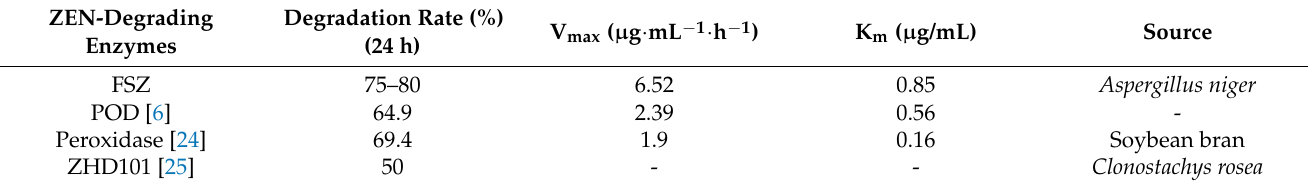
Figure 4. Degradation kinetics of FSZ: ( A ) nonlinear fitting of FSZ’s Michaelis equation; ( B ) Lin- eweaver–Burk (LB plot) of FSZ degradation; ( C ) dynamic degradation kinetic curve of FSZ degra- dation. Table 2. Comparison of the degradation properties of FSZ with other known ZEN-degrading en- zymes.